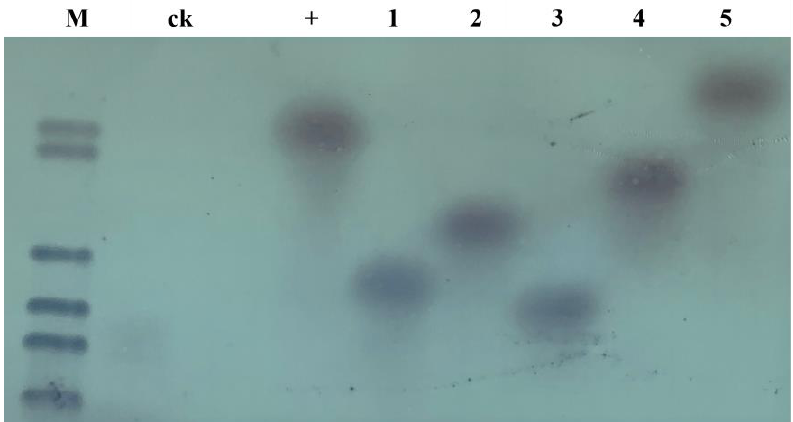
Figure 4. PCR detection of Cas9 in some T 2 generation transgenic plants: ( A ) 1–3 transgenic positive plants; ( B ) 1–3 transgenic positive plants; ( C ) 1–3 transgenic positive plants; ( D ) 1–6 transgenic positive plants; ( E ) 1–3 transgenic positive plants; ( F ) 1–4 transgenic positive plants. M: DL2000 DNA marker; +: positive plasmid; -: negative control.